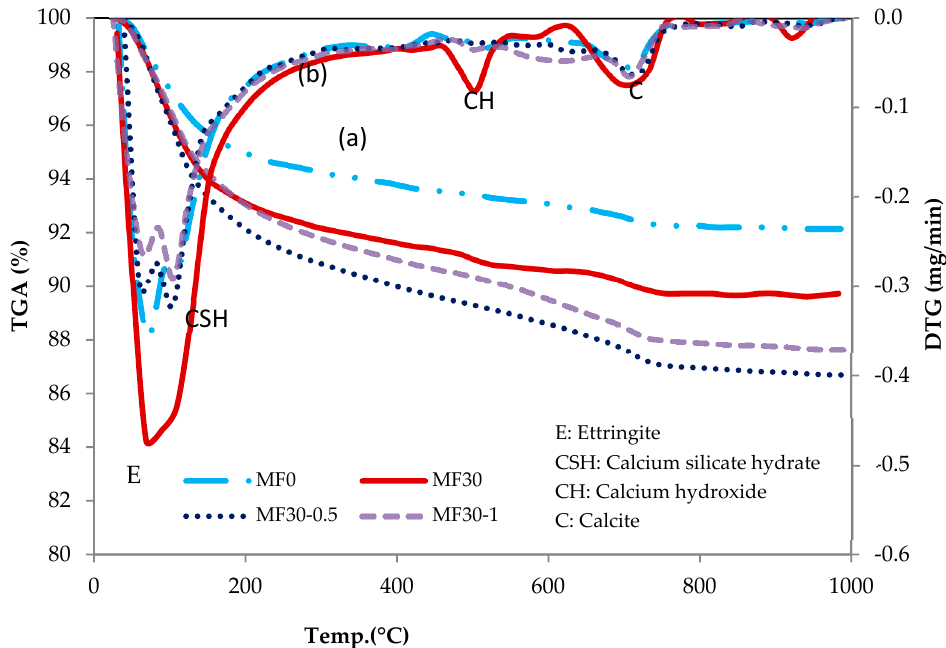
Figure 12. (a) TGA and (b) DTG curves for MF0, MF30, MF30-0.5, and MF30-1. The DTG and TGA curves for MF30, MF30-0.5, and MF30-1 at 91 days are shown in Figure 12. Ettringite (E) diffraction peaks were observed at 65 ◦ C. Diffraction peaks of CSH were found at about 110 ◦ C and 200 ◦ C. CH diffraction peaks could be seen at about 500 ◦ C. All of these diffraction peaks in MF30 were higher than those in MF30-0.5 and MF30-1. From the figure, it is clear that using the AEA reduced the diffraction peaks of CH and